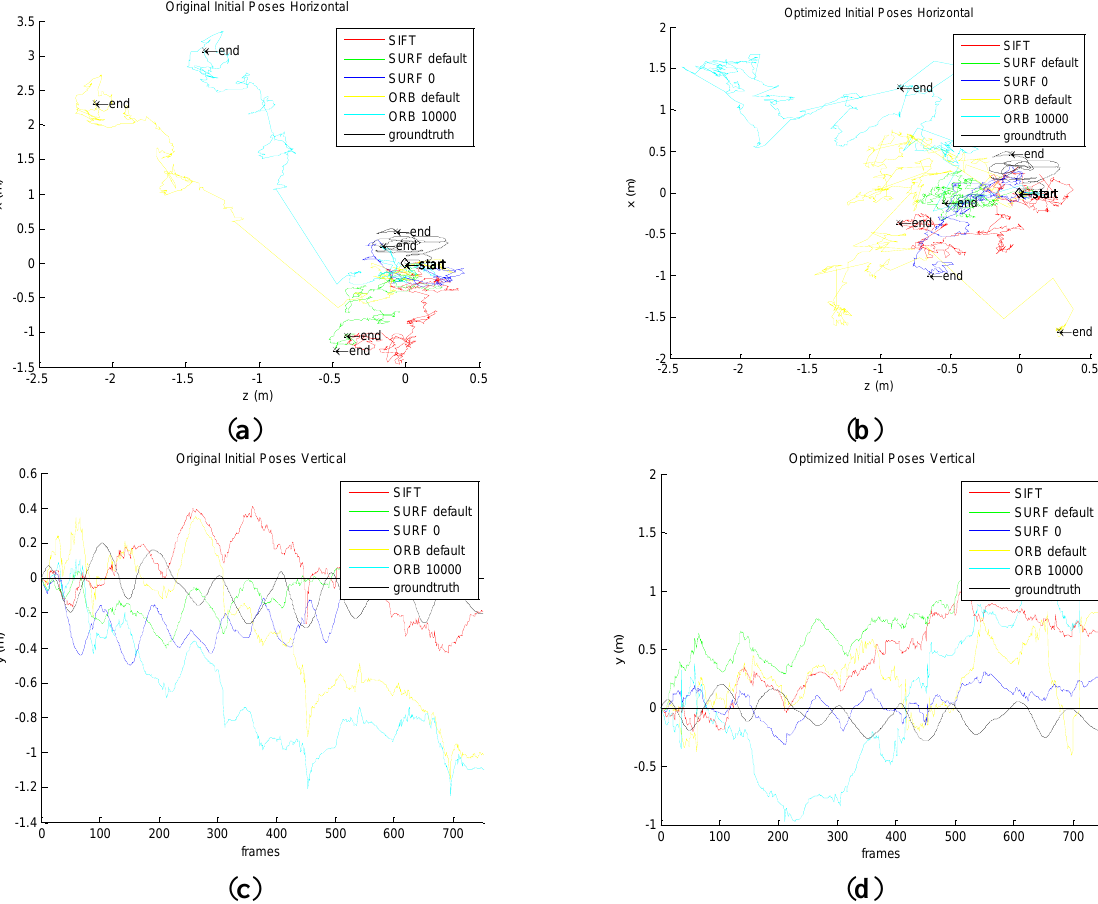
Figure 10. Comparison of the original and the improved algorithm for transformational error and rotational error. ( a ) The transformational error in original; ( b ) The transformational error in improved; ( c ) The rotational error in original; ( d ) The rotational error in improved.